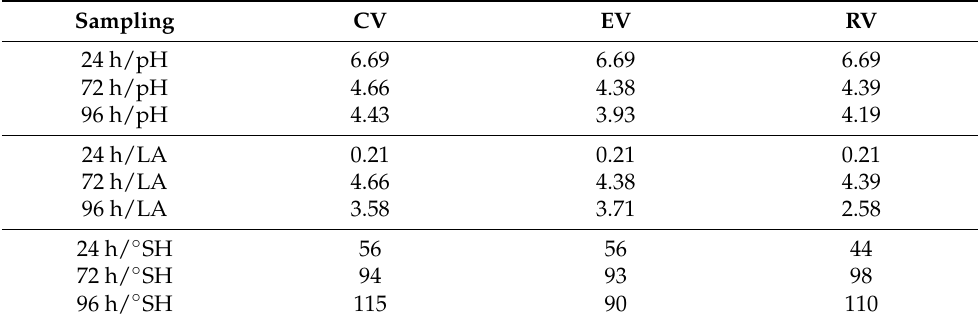
Table 2. The values of pH, lactic acid (g/100 g), and acidity ( ◦ SH) during cheese